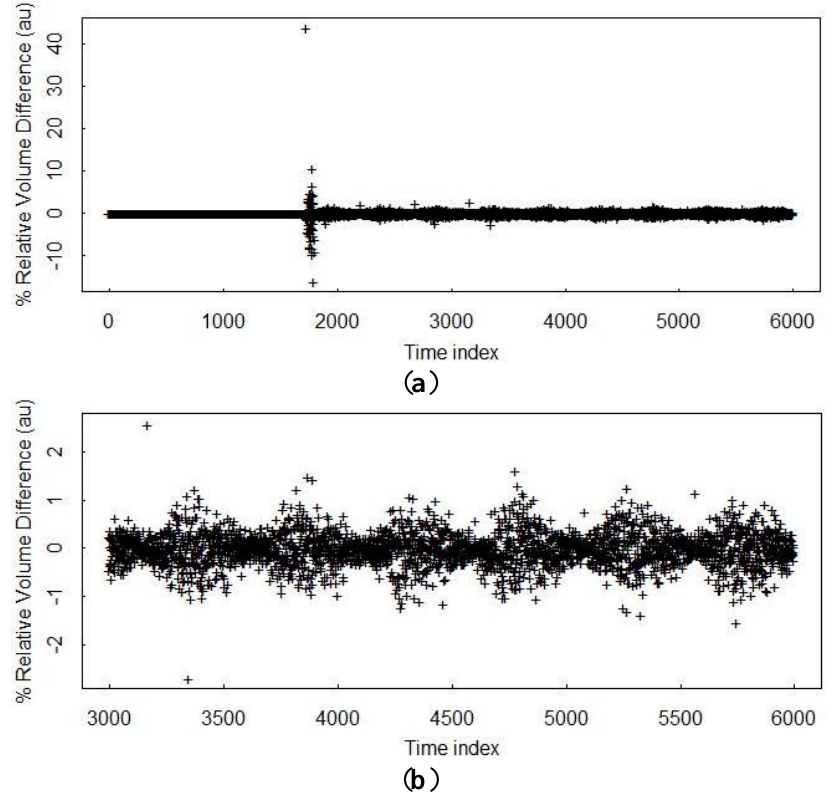
Figure 2. Illustration of synchronization error in an aqueous tank modeled in the System Performance Model (SPM). In ( a ), the synchronization error is present but a large volume residual occurred at the beginning of material flow near minute 1700 so synchronization errors are almost not visible. In ( b ), a relatively short section of time is plotted, and synchronization error is approximately a −1 to 2 percent effect (in arbitrary units, au, because this is percent relative